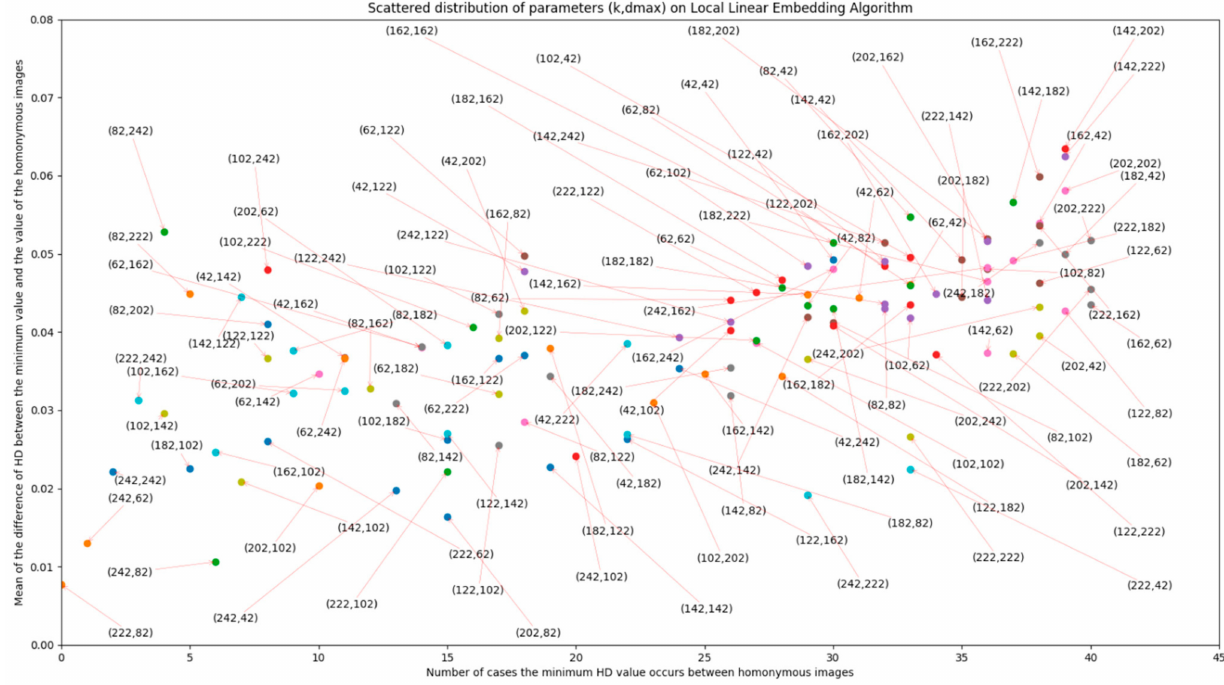
Figure A1. Number of correct matches (per 60 possible pairs) depending on the LLE parameter variation and the difference between minimum value and value for homonymous